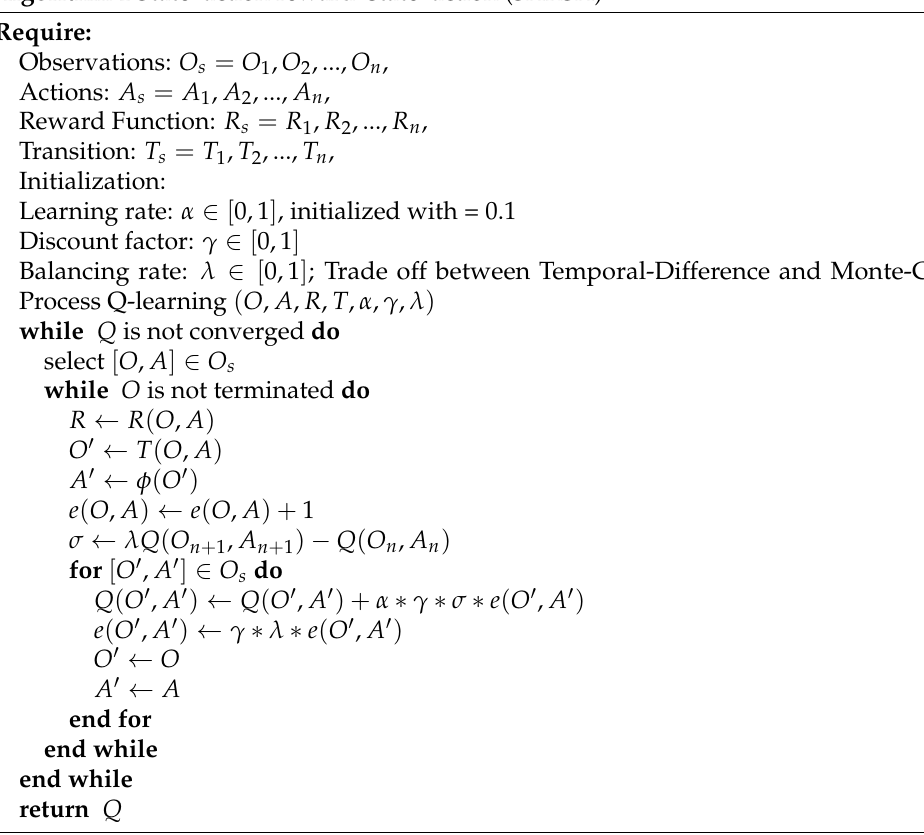
Algorithm 1 State–action reward–state–action